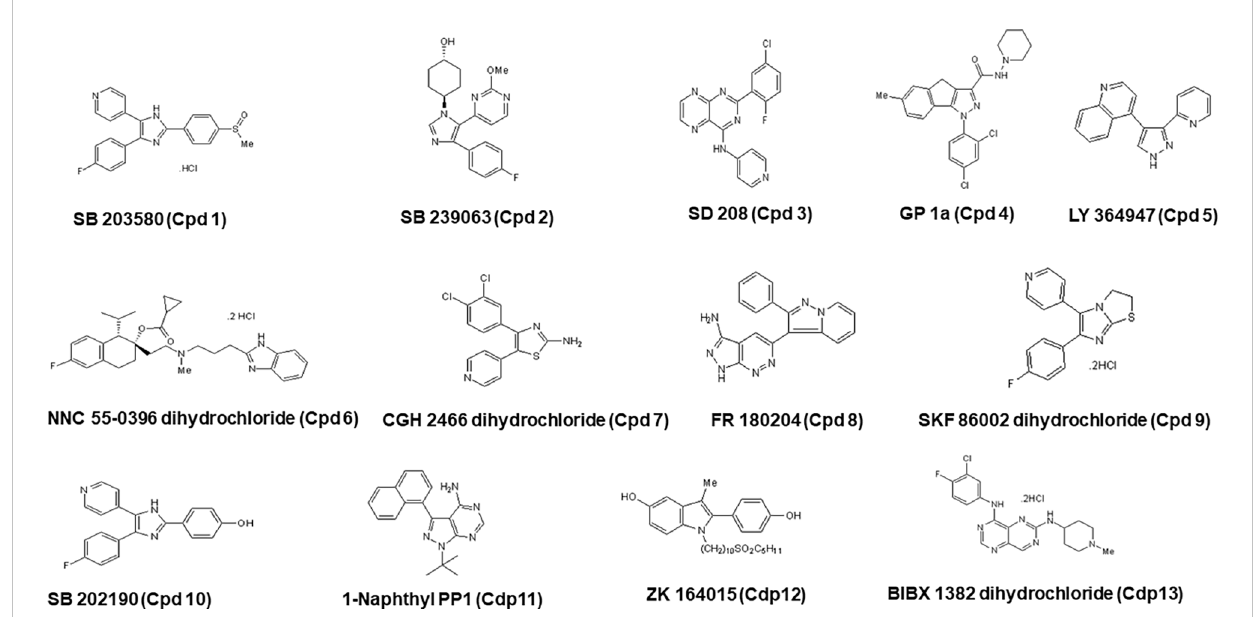
FIGURE 8 Chemical structures of all 12 hits with their corresponding names in the Tocris library, along with the nomenclature used in the present study (Cpd) and with the number corresponding to the order of identi fi